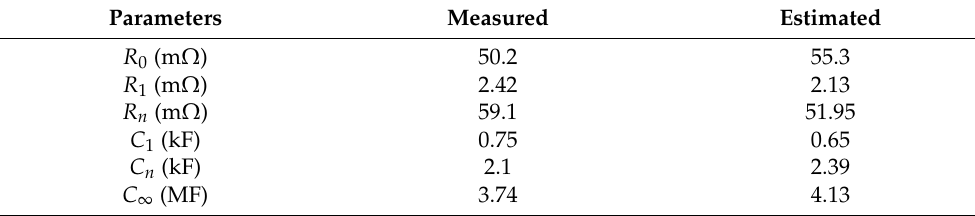
Table 9. Results of Case 2.